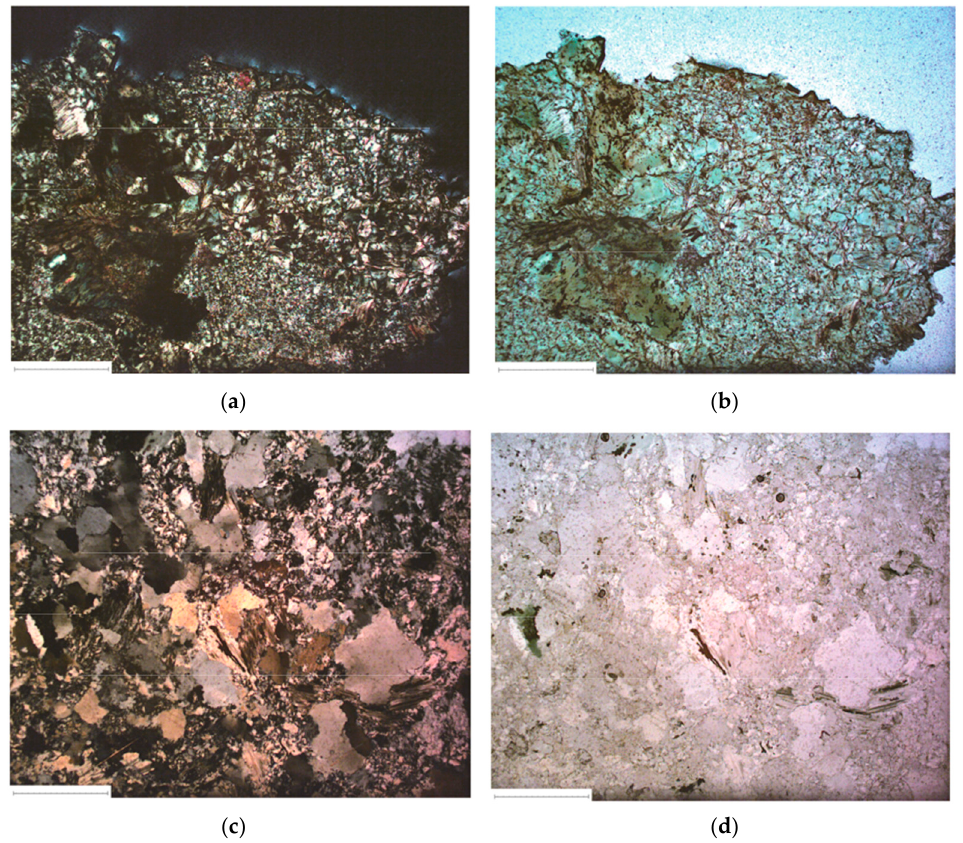
Figure 8. Microphotographs of mould B1: ( a ) crossed nicols; ( b ) parallel nicols. O1 compatible material from the Orani district (Central Sardinia); ( c ) crossed nicols; ( d ) parallel nicols. Graphic scale = 1 mm.